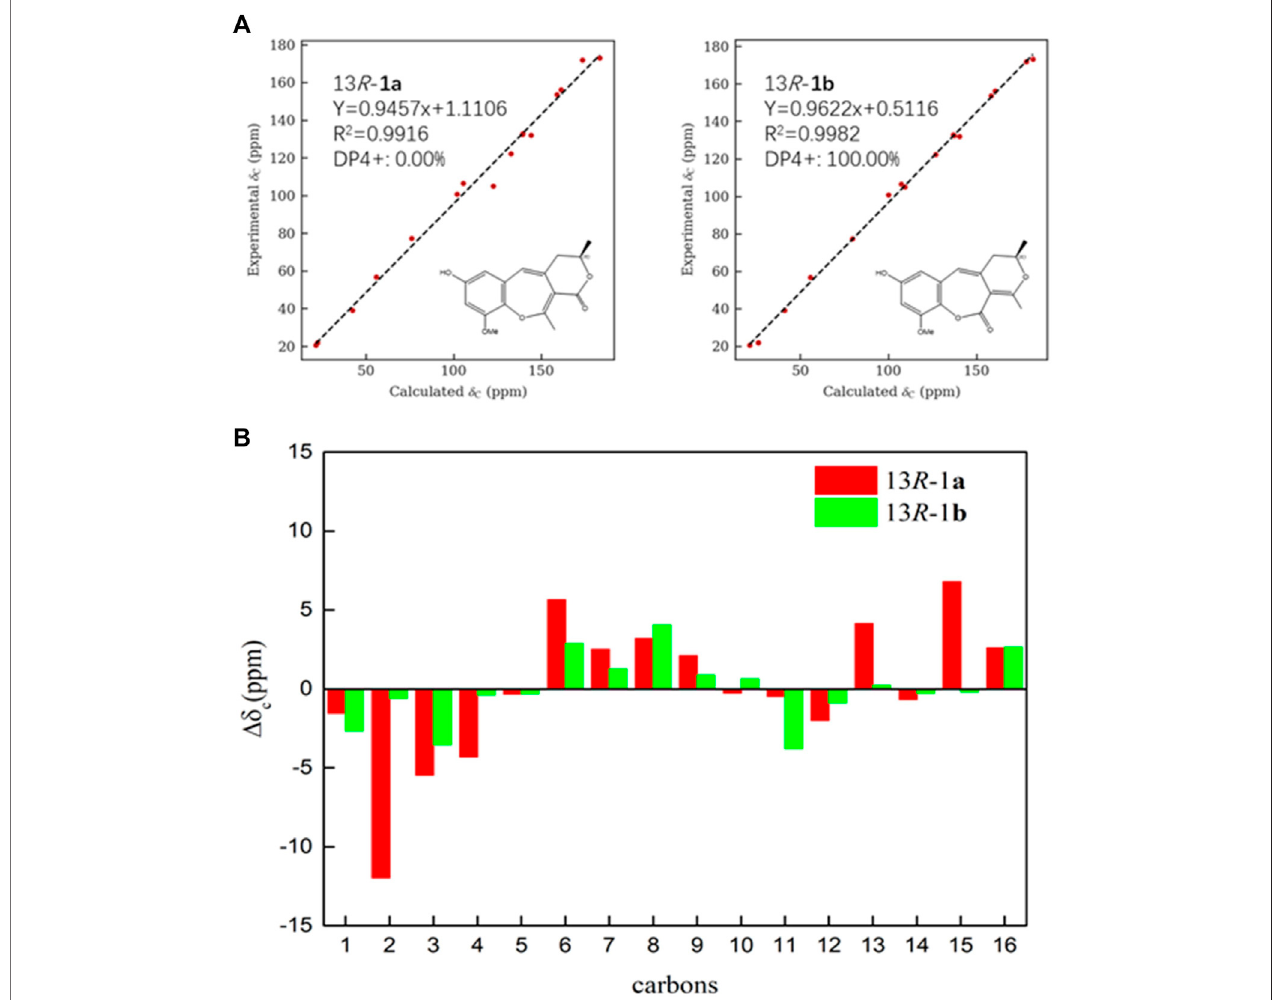
FIGURE 3 | (A) Linear regression fi tting of calculated 13 C chemical shifts of two possible isomers of 1a and 1b with the experimental values (B) Deviation between calculated 13 C chemical shifts of two possible isomers of 1a and 1b with the experimental values.